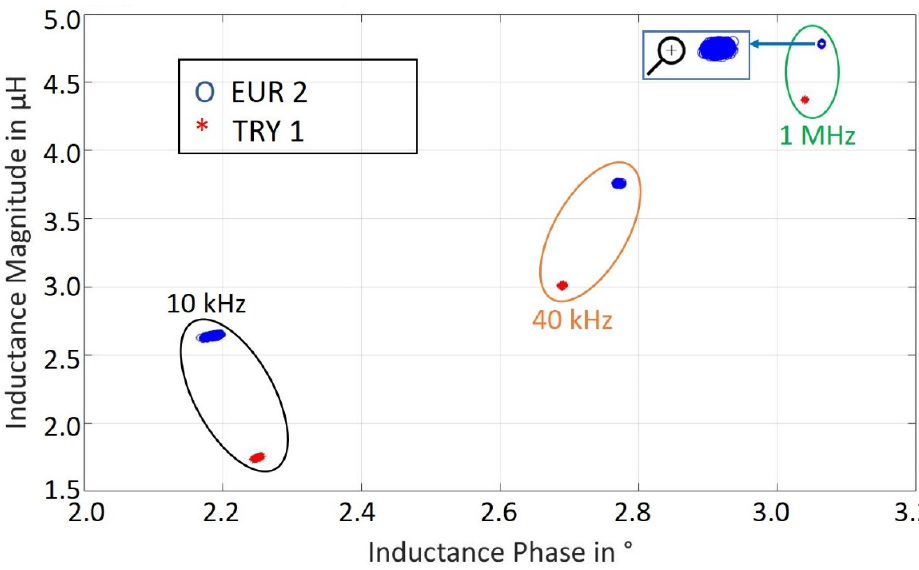
Figure 6. Inductance Ratio vs. Inductance Phase for EUR 2 and TRY 1 Coin Classes at Three Frequencies Measured 10,000 Times Each.